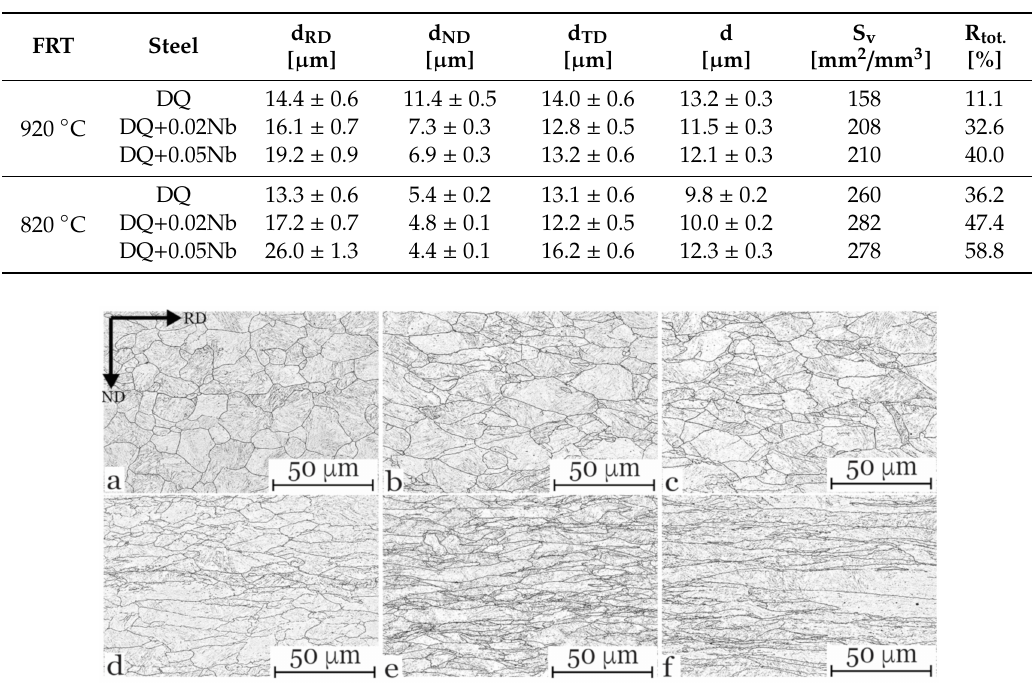
Figure 8. Prior austenite grain boundaries of investigated steels; upper row: FRT 920 ◦ C, lower row: FRT 820 ◦ C. ( a , d ) DQ, ( b , e ) DQ + 0.02Nb, ( c , f ) DQ + 0.05Nb. Picral